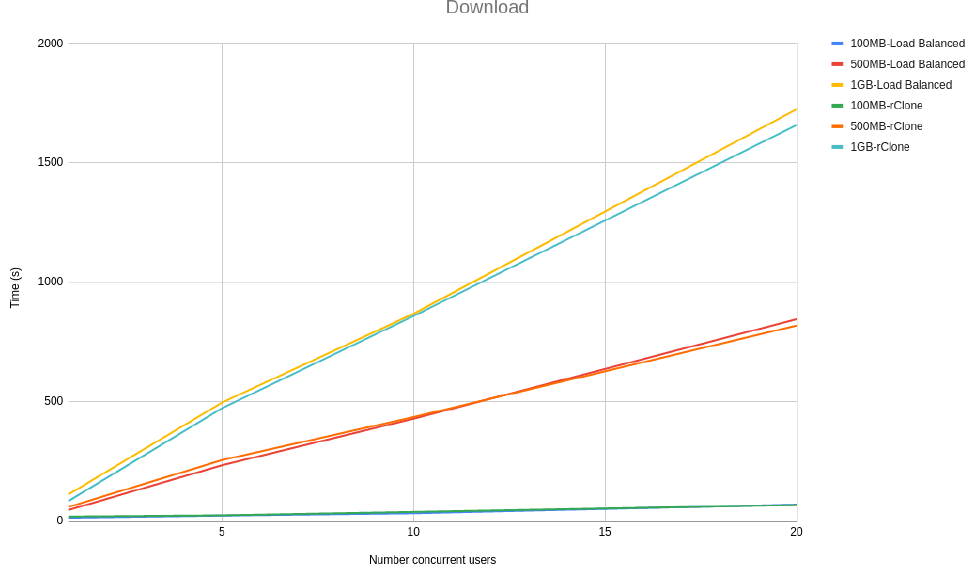
Figure 4. Download scalability